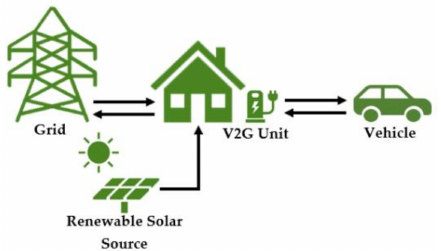
Figure 1. Diagram showing how power is distributed in Vehicle-to-Grid (V2G)